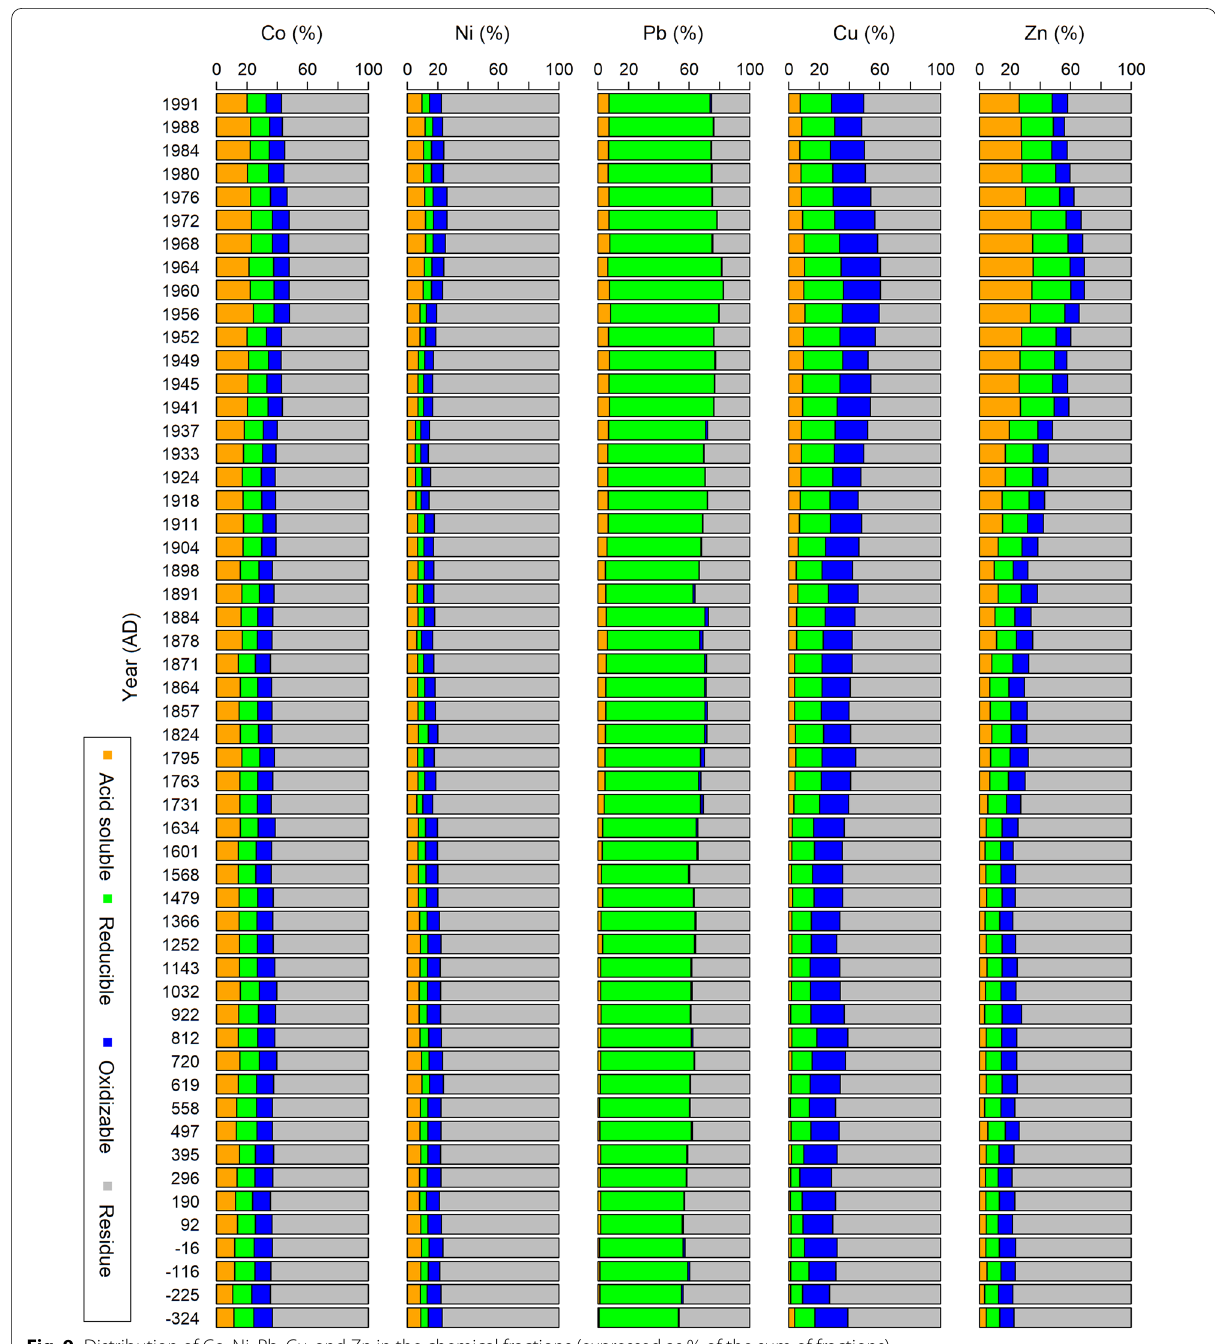
Fig. 9 Distribution of Co, Ni, Pb, Cu, and Zn in the chemical fractions (expressed as % of the sum of